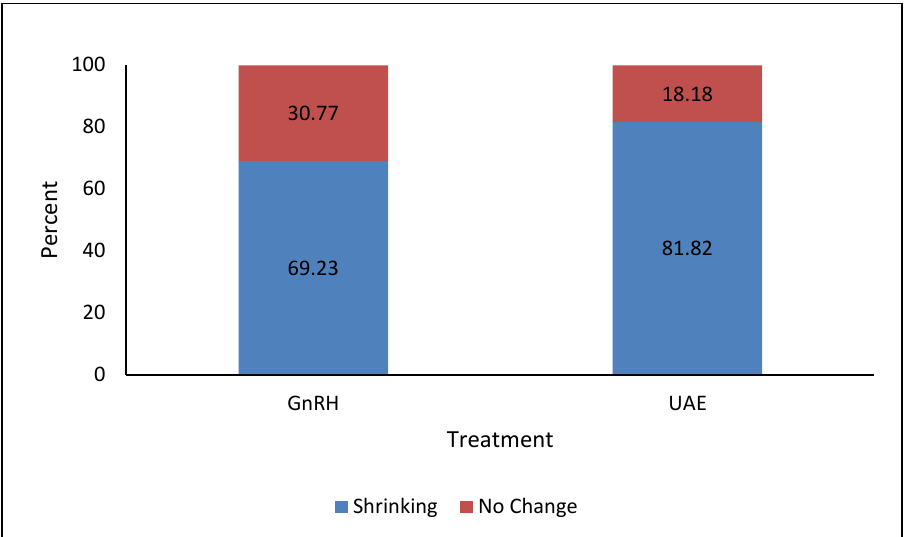
Figure 2. Reduction of fibroid size after pre-treatment with GnRHa or